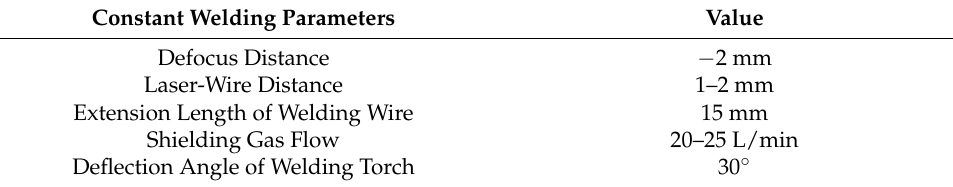
Table 3. Constant parameters of the laser-MAG hybrid welding process.